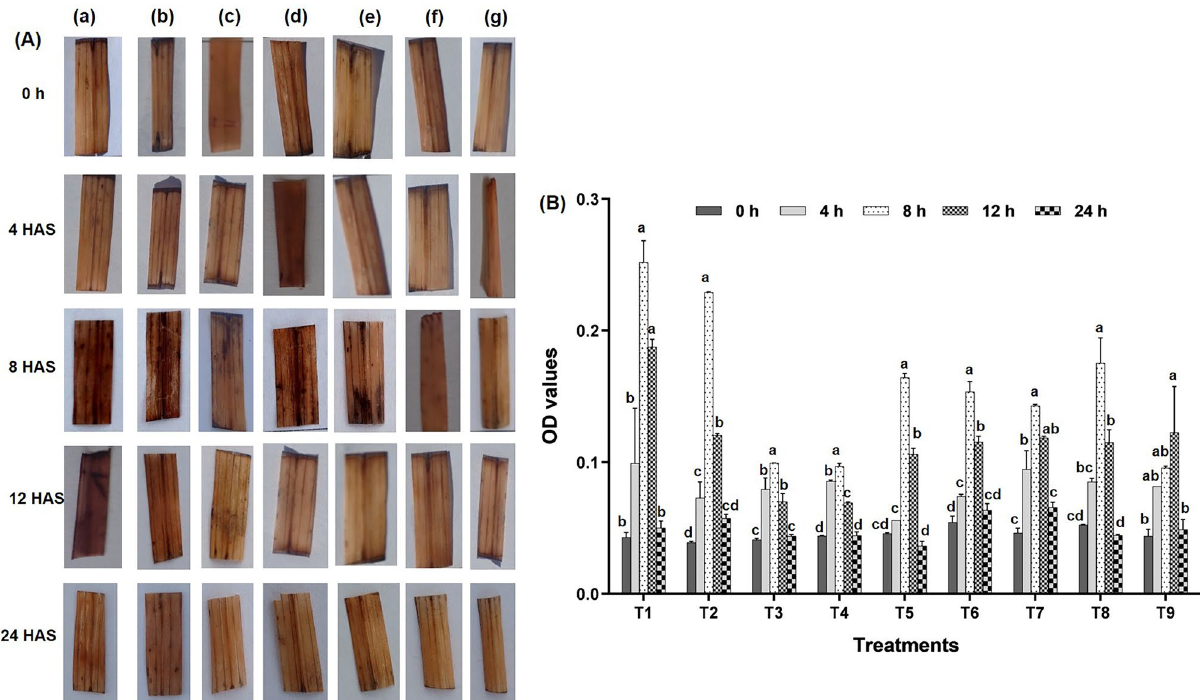
Figure 3. Effect of fungicides on production of hydrogen peroxide ( A ) In vivo localisation of hydrogen peroxide at different interval in response to fungicidal stress (a) T 1 : tricyclazole, (b) T 2 : carbendazim, (c) T 5 : tricyclazole + LBS6, (d) T 6 : tricyclazole + LBD1, (e) T 7 : carbendazim + LBS6, (f) T 8 : carbendazim + LBD1, (g) T 9 : control. ( B ) Estimation of hydrogen peroxide at different intervals (Legends: T 1 : Tricyclazole, T 2 : Carbendazim,